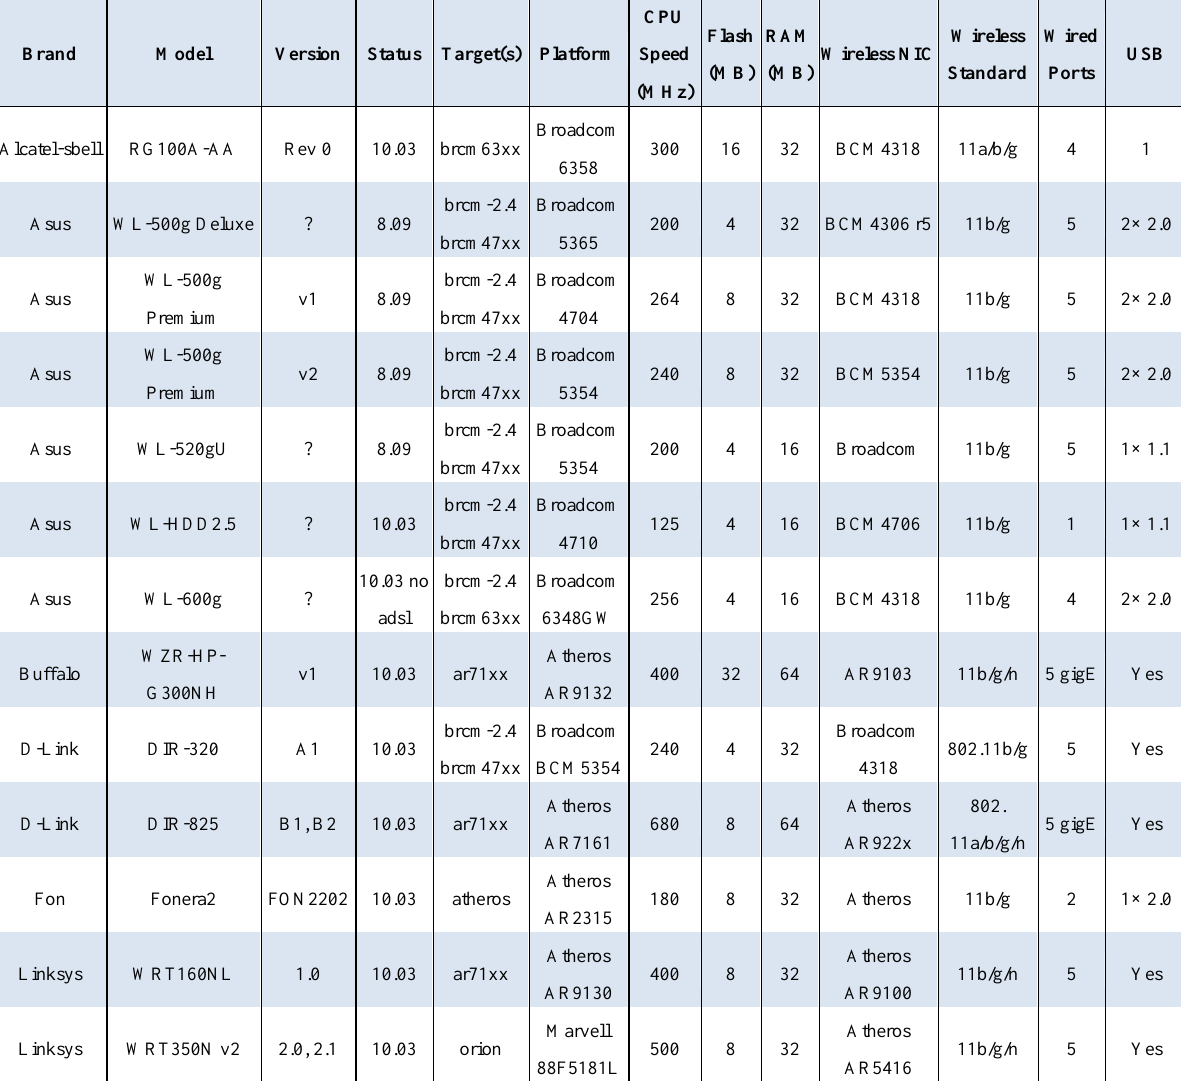
Table 1. Available hardware comparison for sensor